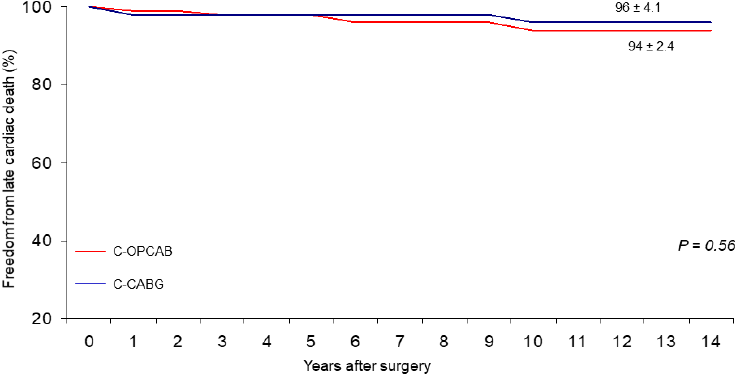
Figure 3. Freedom from late cardiac death. Table 2. Actual rates of adverse events observed during follow-up, not including in-hospital results.